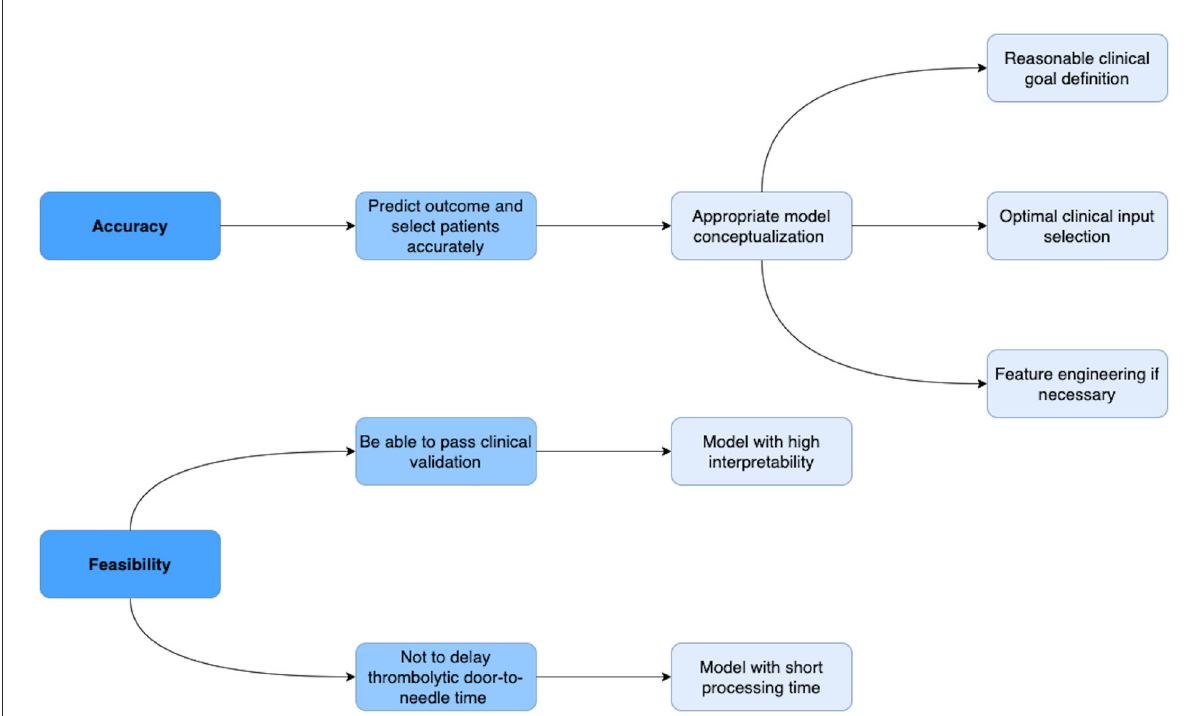
FIGURE2 Blueprint of the criteria a machine learning model should meet in order to be accurate and feasible in assisting thrombolysis therapy. In terms of accuracy, a model should be able to predict risks and benefits and select target patients who could benefit the most from thrombolysis therapy with high accuracy. The accuracy of the model largely depends on the conceptualization, which consists of reasonable clinical goal definition, optimal clinical input selection, and appropriate feature engineering if necessary. In terms of feasibility, in order to pass the clinical validation, a model should have high interpretability; in order not to delay the door-to-needle time, the model needs to calculate the output in a short